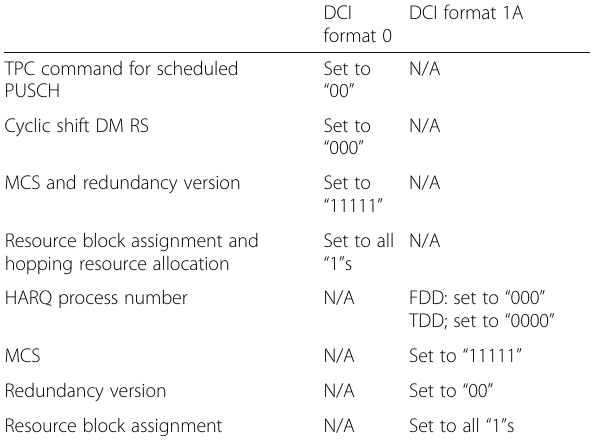
Table 3 Special fields for SPS release PDCCH validation